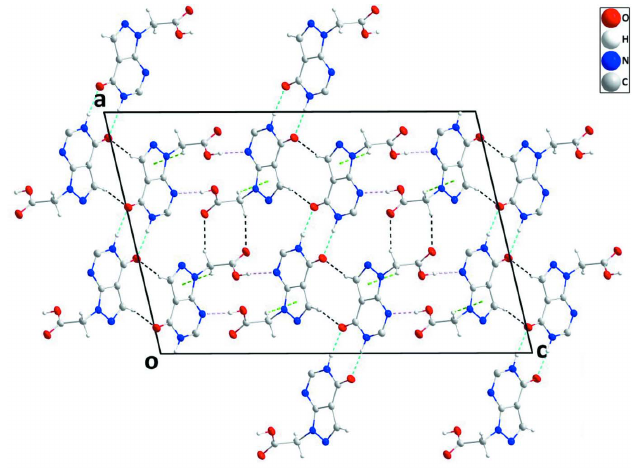
Figure 2 View of the crystal packing along the b- axis direction with N—H (cid:2)(cid:2)(cid:2) O, O—H (cid:2)(cid:2)(cid:2) N and C—H (cid:2)(cid:2)(cid:2) O hydrogen bonds shown, respectively, by light- blue, pink and black dashed lines. C—H (cid:2)(cid:2)(cid:2) (cid:2) (ring) interactions are shown by green dashed